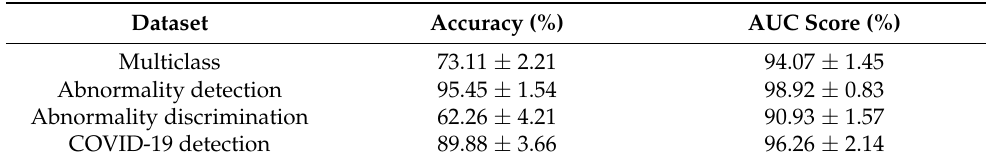
Table 3. Classification results. The mean accuracy for the complete 10-fold and standard deviation for the performance between the 10-fold are also